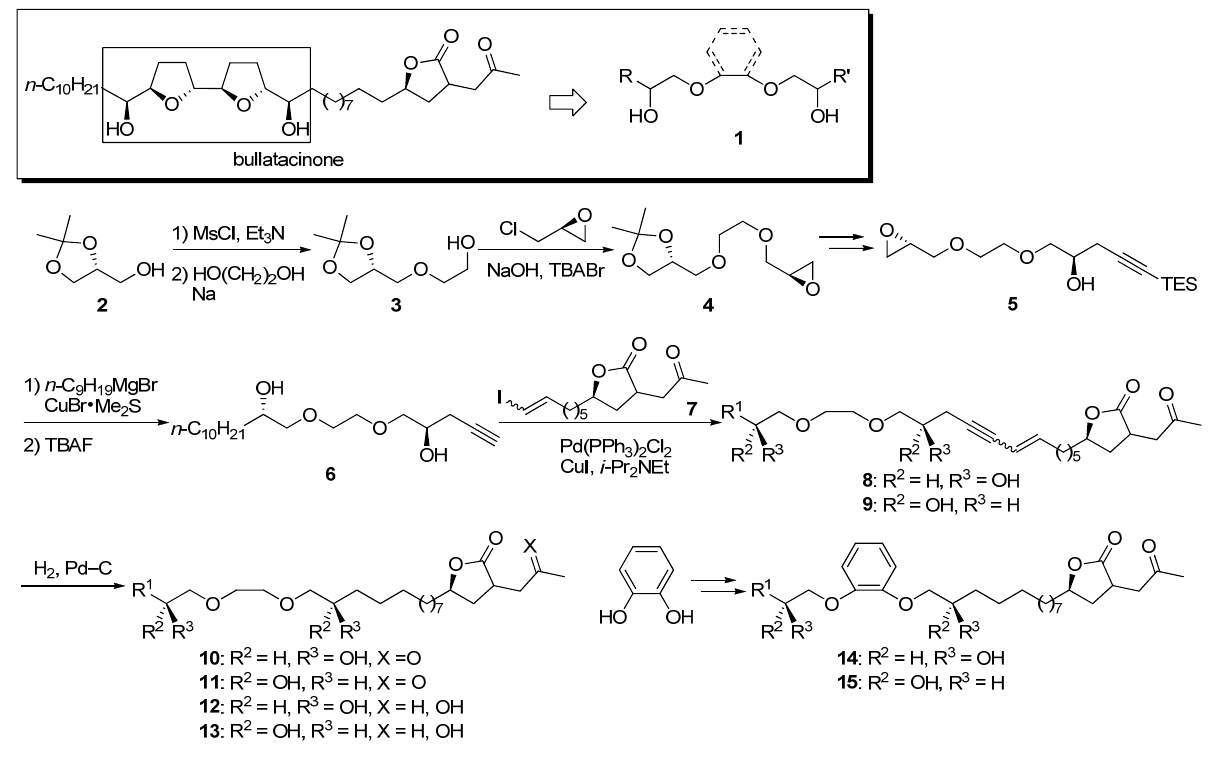
( μ M) of synthetic analogues against L1210 cell Table 1. IC 50